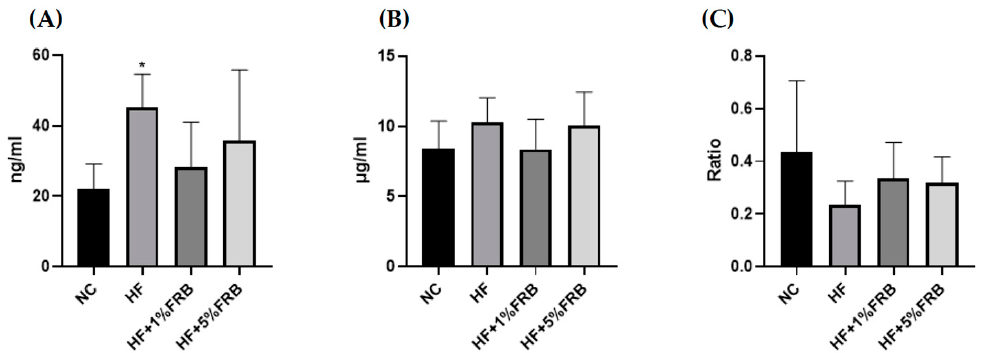
Figure 6. Effects of the water extract of fermented rice bran (FRB) on plasma adipokine levels in aged rats with high-fat (HF) diet feeding. Plasma levels of ( A ) leptin, ( B ) adiponectin, and ( C ) the adiponectin/leptin ratio. Values are presented as the mean ± standard deviation ( n = 6). * p < 0.05